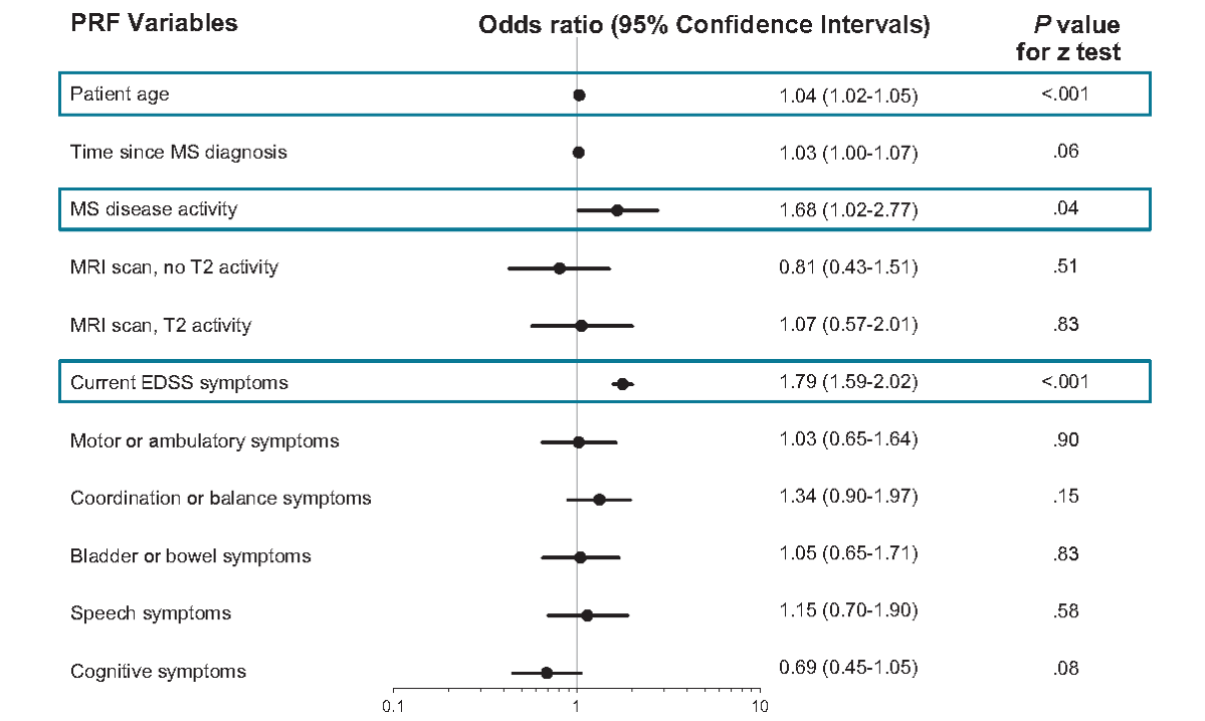
Figure 2. Multivariate regression analysis: variables that are predictors of progression to secondary progressive multiple sclerosis. Disease activity is Physician-reported multiple sclerosis disease activity based on the physician’s overall perception of the patient’s disease activity, ranging from “no activity to high activity” (no specific definition of disease activity was provided to the physicians); an odds ratio >1 implies a higher risk of secondary progressive multiple sclerosis; the blue box highlights the significant predictors. EDSS: Expanded Disability Status Scale; MRI: magnetic resonance imaging; MS: multiple sclerosis; PRF: patient record form; SPMS: secondary progressive multiple sclerosis; T2: transverse relaxation time. Black dots indicate odds ratio (point estimate); black line indicates the 95% confidence interval.